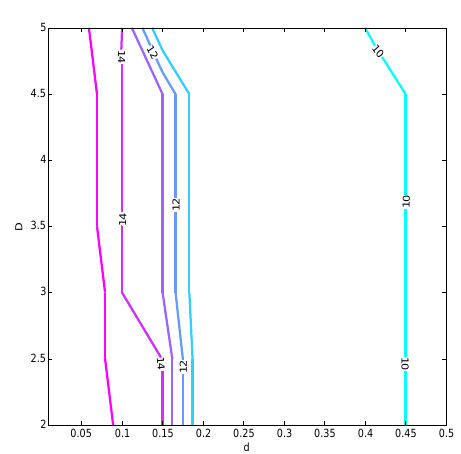
Fig. 5: Estimations of L max ( d,D ) for D ≥ δ = 2 .